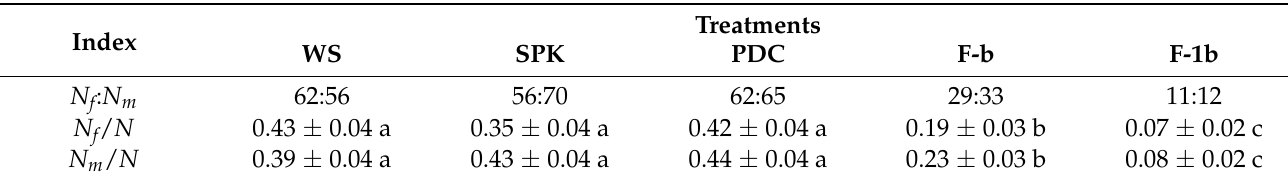
Table 3. The proportion of female and male adults emerging from eggs used at the beginning of the life table study according to wheat